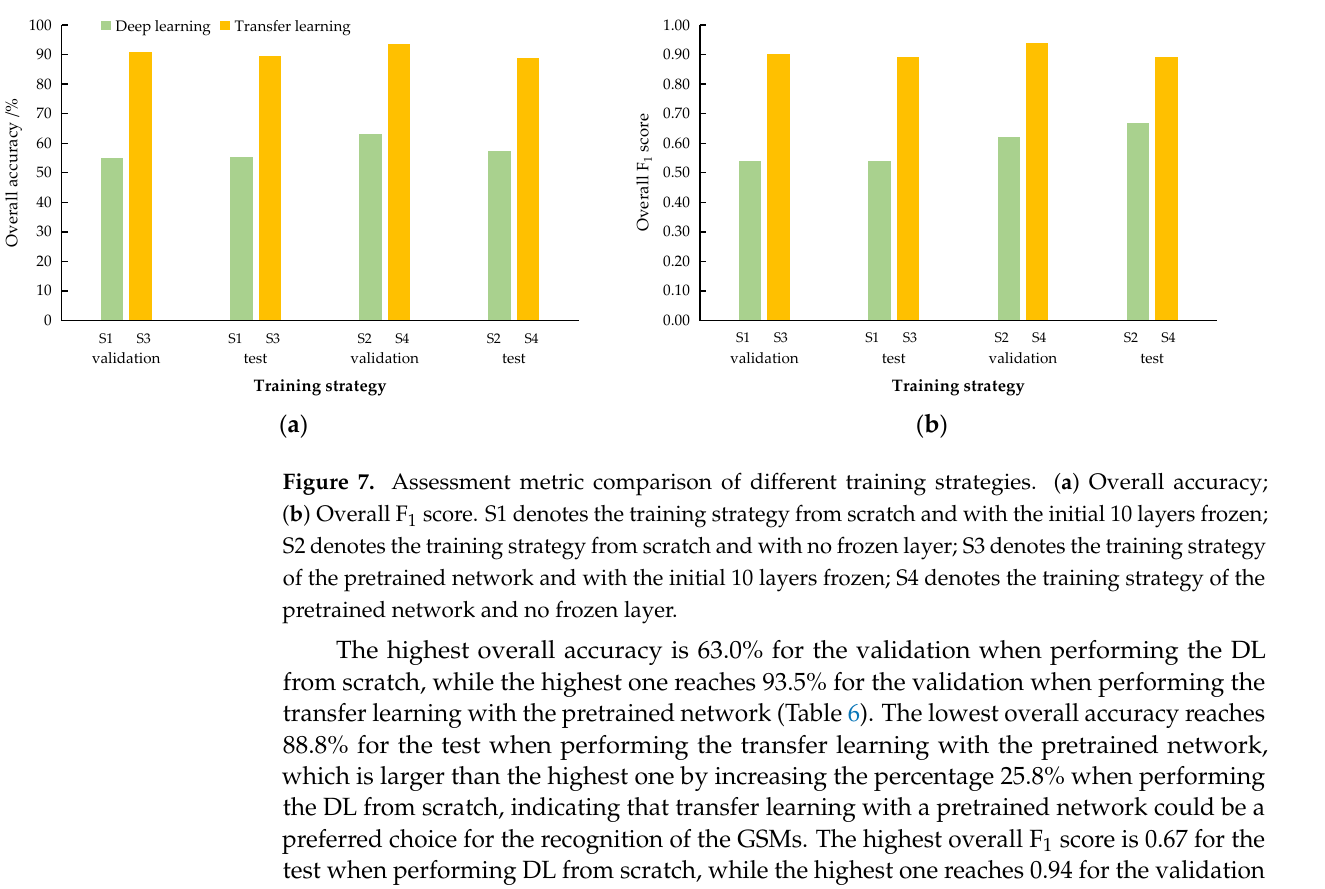
* OA denotes overall accuracy. The division ratio is 0.8:0.1:0.1 for the training (400 images), testing (50 images), and validation (50 images) subsets. The same parameters for training were set.